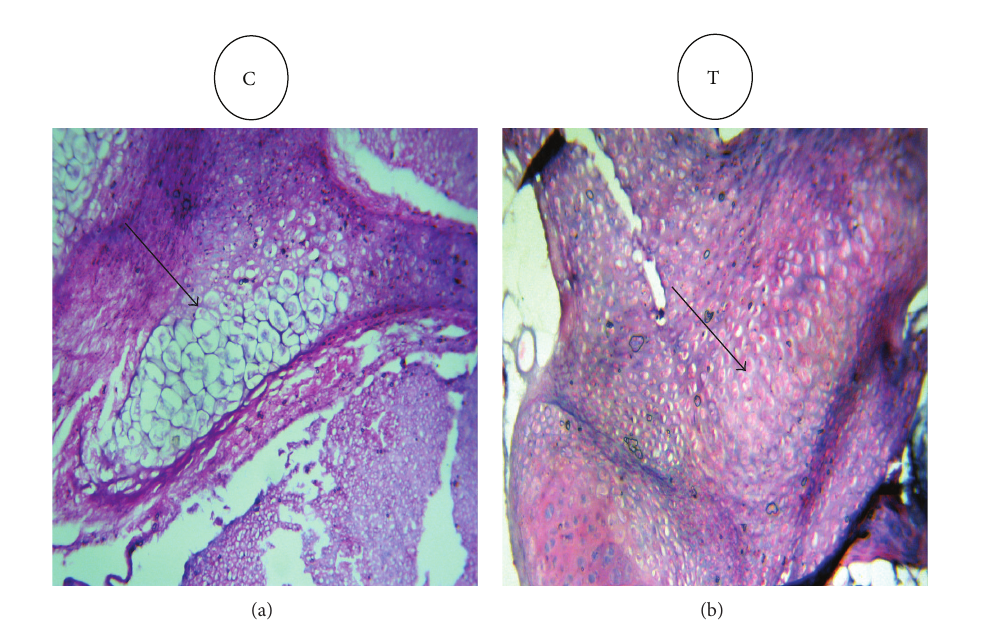
Figure 2: Cross-section through the spinal cord and thoracic vertebrae of fetuses at 20th day of gestation, showing absence of ossification in treated group (T) (2000 mg norfloxacin/Kg ⋅ b ⋅ wt from 6th to 15th day of pregnancy) in comparison with normal ossification in control group (C) ( × 10 H &